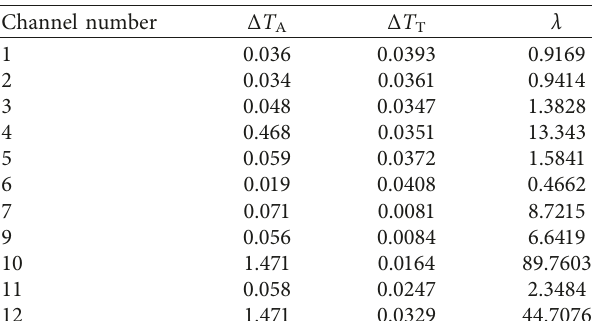
Figure 11: Clustering of arrival times and choice of refer station. (a) Clustering results using k-means; (b) distance (normalized value) of current station and cluster A. Table 4: Time difference between station 8 and other stations.